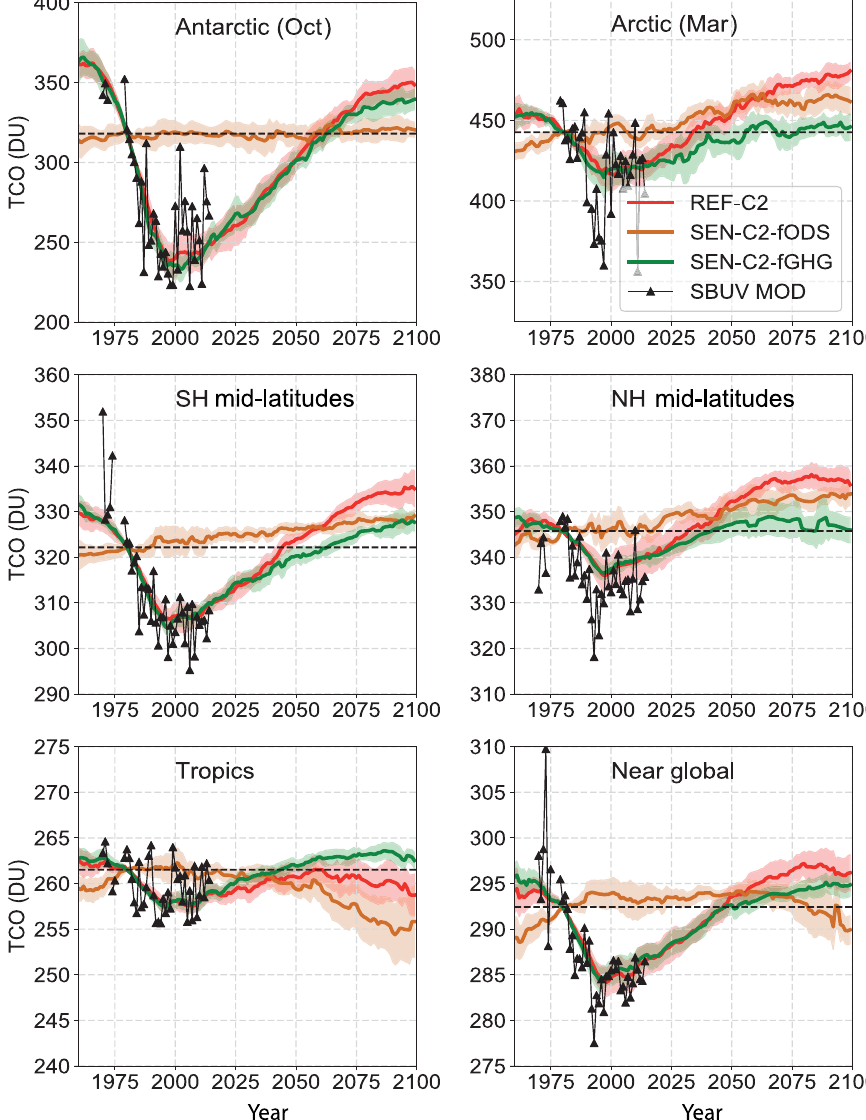
Figure 3. MMM1S total column ozone time series (DU) from REF-C2 (red), SEN-C2-fGHG (dark green), and SEN-C2-fODS (brown) simulations for five latitudinal bands and the near-global (60 ◦ S–60 ◦ N) mean (see main text). The dashed black lines show the 1980 reference value for each latitude band. Also shown are the merged SBUV